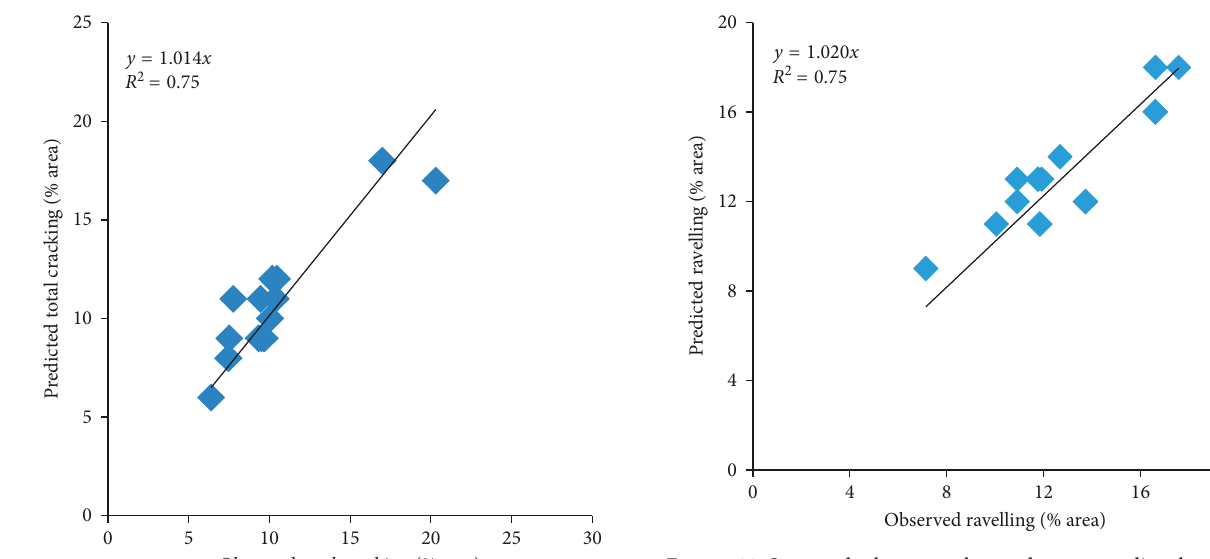
Figure 22: Scatter plot between observed versus predicted ravelling for validation (2015).